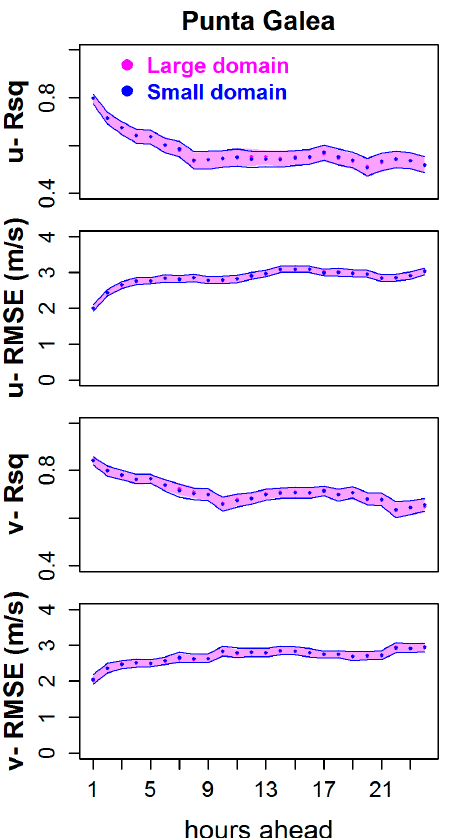
Figure 7. R 2 and RMSE verification indices for the u and v wind components for the coming 24 h at Punta Galea, using the RF method to compare the results in two different domains.